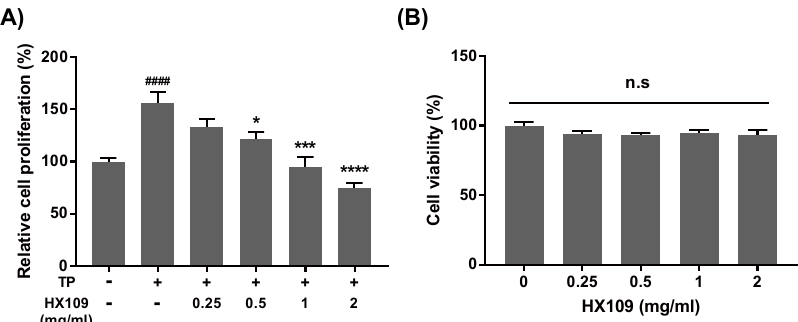
Figure 3. HX109 suppressed androgen-dependent proliferation of LNCaP cells. LNCaP cells were plated in culture media for 24 h followed by androgen starvation using phenol red free RPMI 1640 containing 10% charcoal-stripped serum for 24 h. After androgen starvation, LNCaP cells were treated with or without 100 nM TP and cultured in the presence of various concentrations of HX109 for 72 h. Cell proliferation was measured by WST-1 assay. ( A ) Effects of HX109 on the TP-induced proliferation of LNCaP cells. ( B ) Cytotoxicity effects of HX109. #### p < 0.0001 (one-way ANOVA) compared with control, * p < 0.05, *** p < 0.001, **** p < 0.0001 (one-way ANOVA) compared with TP only. n.s, not significant. Values are normalized to control. All data are shown as mean ± S.E.M. of three independent experiments. ‘+’ means ‘treated with TP or HX109’, if it is on the right side of TP, it means ‘treated with TP’; if it is on the right side of HX109, it means ‘treated with HX109’. ‘ − ’ means ‘not treated with TP or